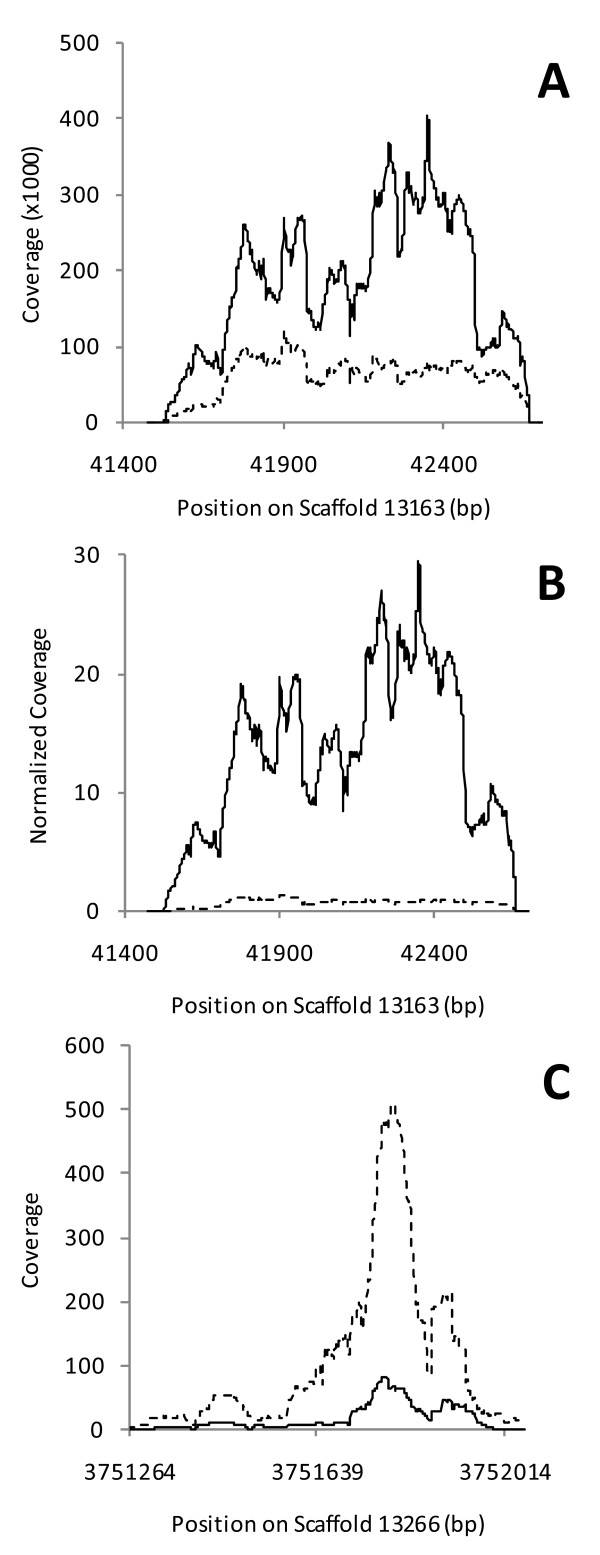
Coverage of the 18S rRNA and actin genes. The coverage of reads across the 18S rRNA (Panel A) and actin (Panel C) genes was determined by mpileup in samtools and compared between total RNA (solid line) and Ribo-Zero-subtracted RNA (dashed line). For the 18S rRNA, the Ribo-Zero-subtracted sample contained 66% fewer rRNA reads when compared to the total RNA sample. When the 18S rRNA results are normalized relative to actin, a 95% reduction in the rRNA is seen (Panel B). The 18S rRNA is only partially sequenced in the reference genome with a gap in the scaffold to the immediate right of this region.